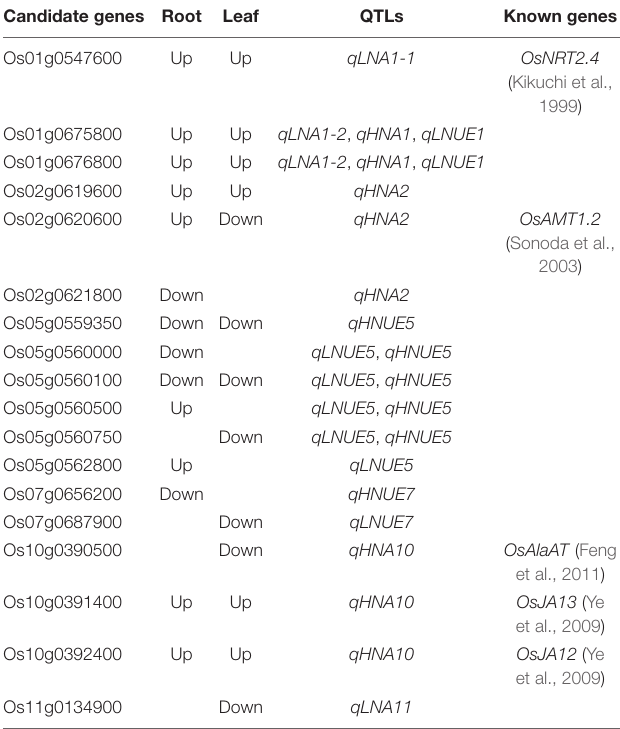
TABLE 2 | Candidate genes differentially expressed under LN conditions. Candidate genes Root Leaf QTLs Known